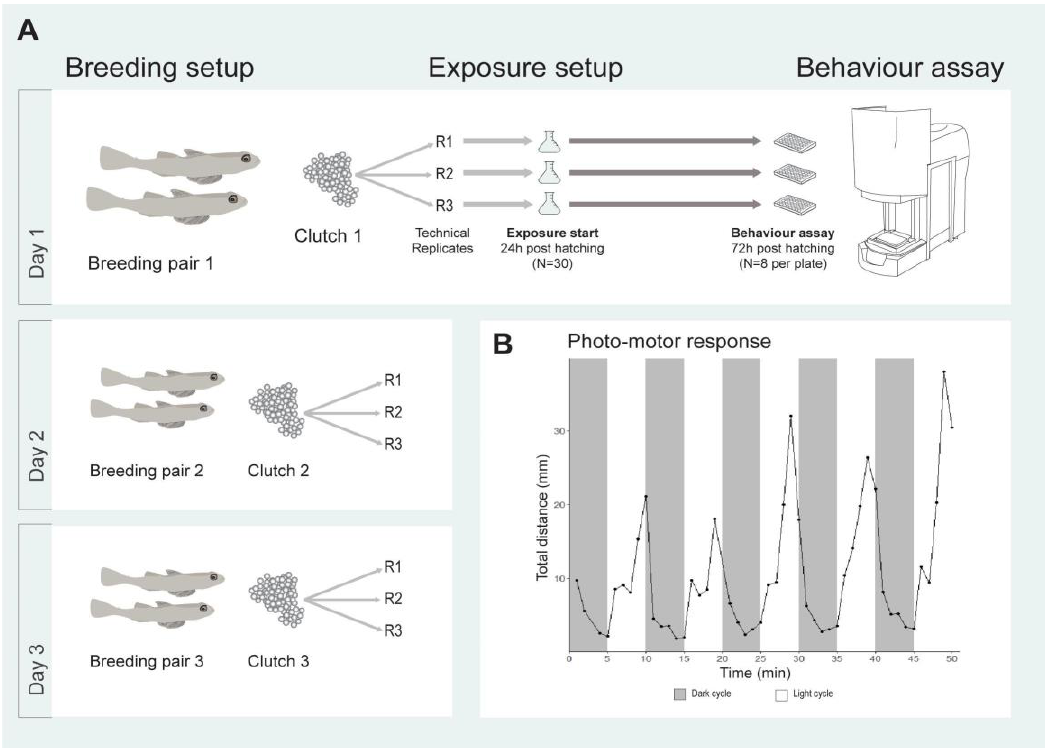
Figure 5. Breeding setup and experimental design for sand goby larvae exposures ( A ) and behavioural toxicity assay utilizing alternating light and dark cycles ( B ). The locomotive response of unexposed sand goby larvae is presented.